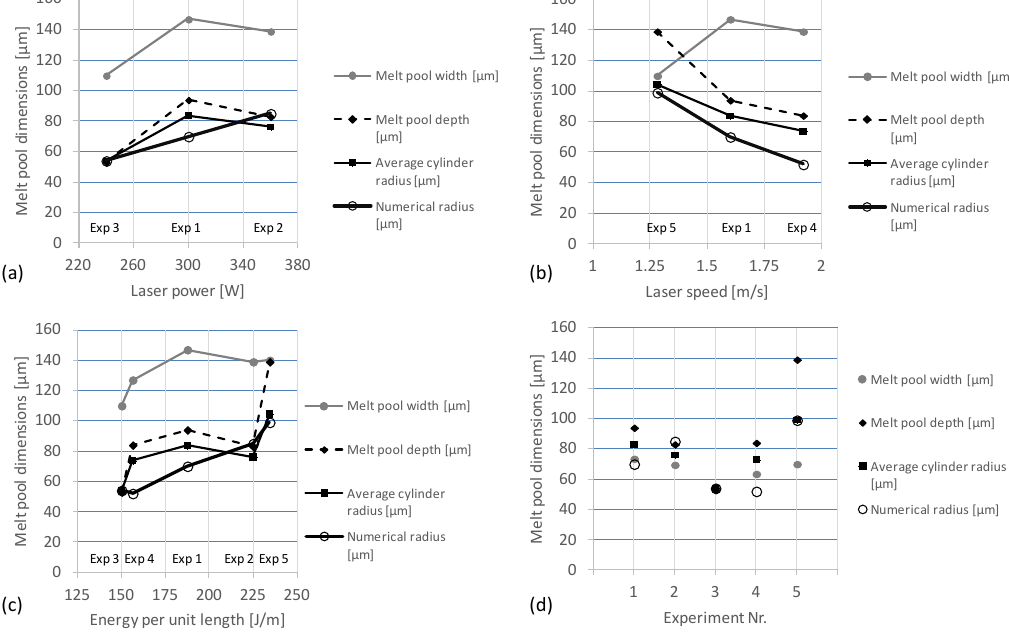
Figure 9. Numerical vs. experimental results of the melt pool dimensions with varying laser power ( a ), laser speed ( b ), and energy per unit length ( c ). The deviation of the proposed analytical model compared to real melt pool dimensions for all five experiments is summarized in ( d ).